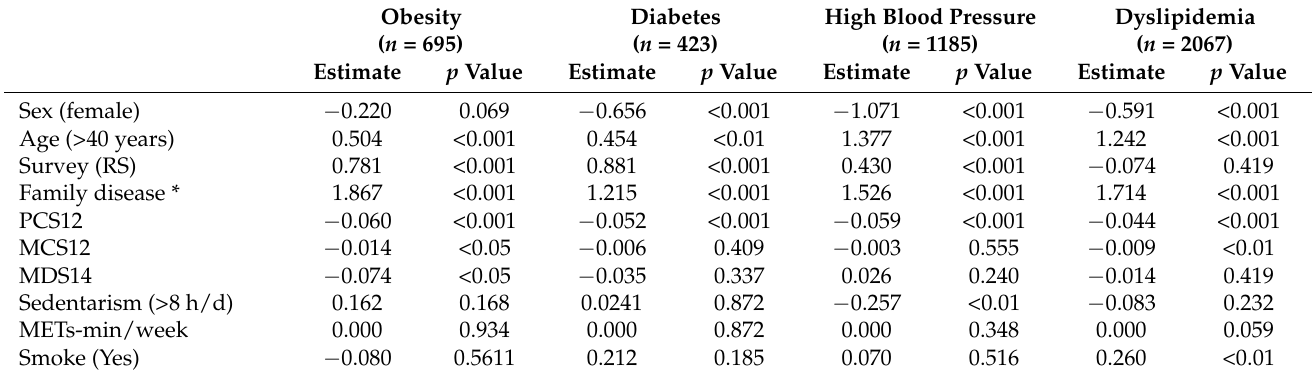
* Family disease refers to each disease of the same column. Logistic regression analysis was used to examine the association of each variable with the presence or absence of each metabolic disease (obesity, diabetes, HBP and dyslipidemia). Threshold significance was set at p <